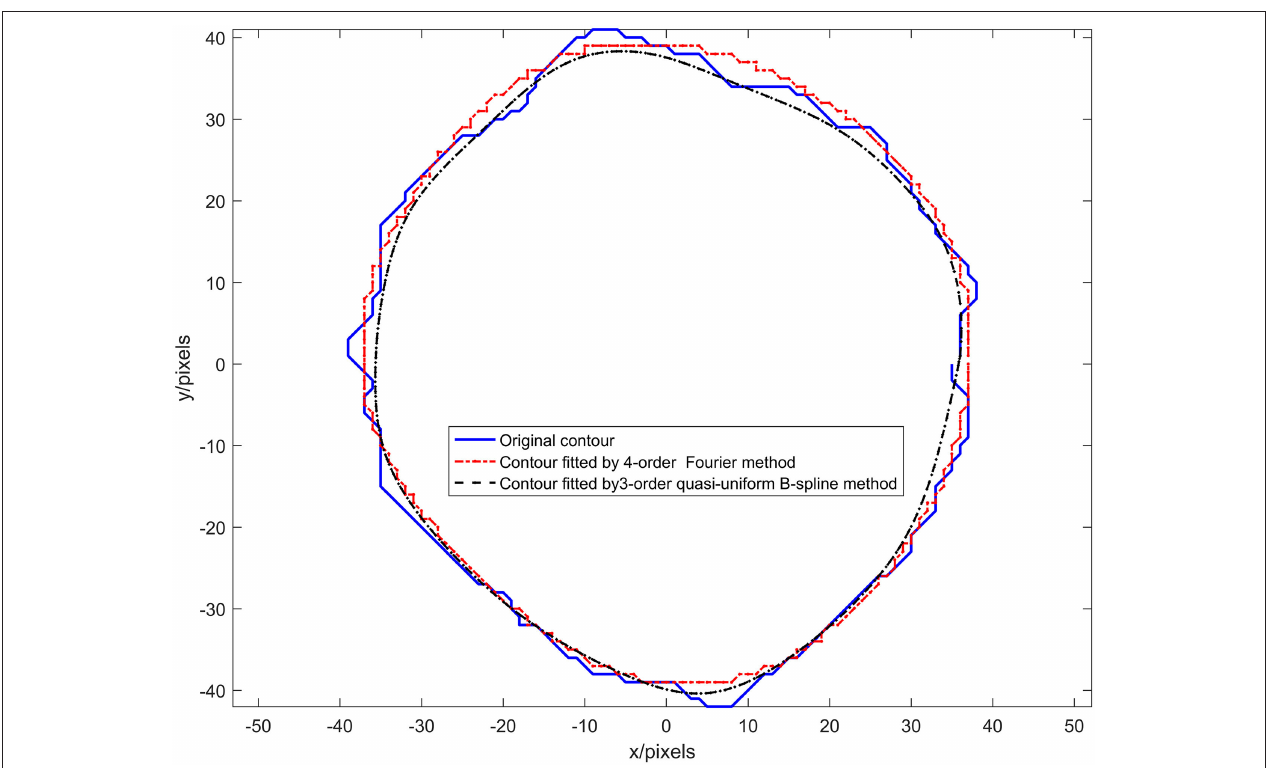
FIGURE 4 | Results of experiment 1.